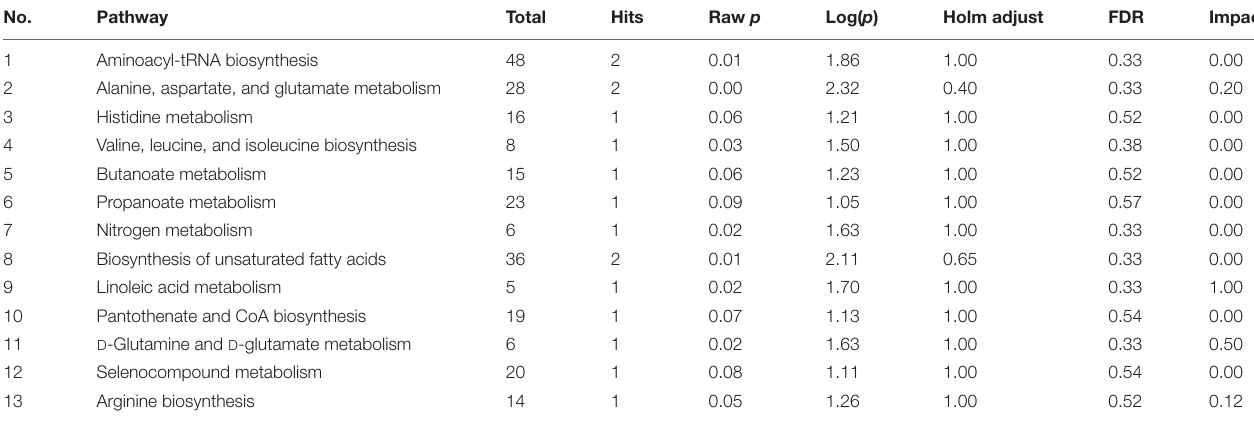
TABLE 3 | Metabolite pathway changes in hippocampus.